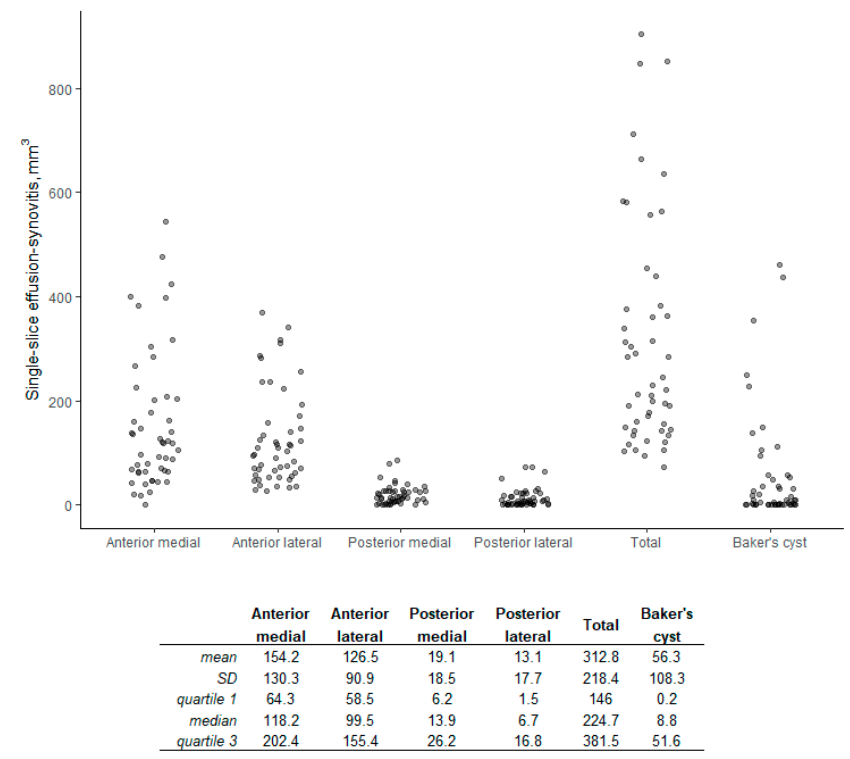
Figure 3. Distribution of single-slice volume with summary statistics (KL 2–3 sample, n = 50).